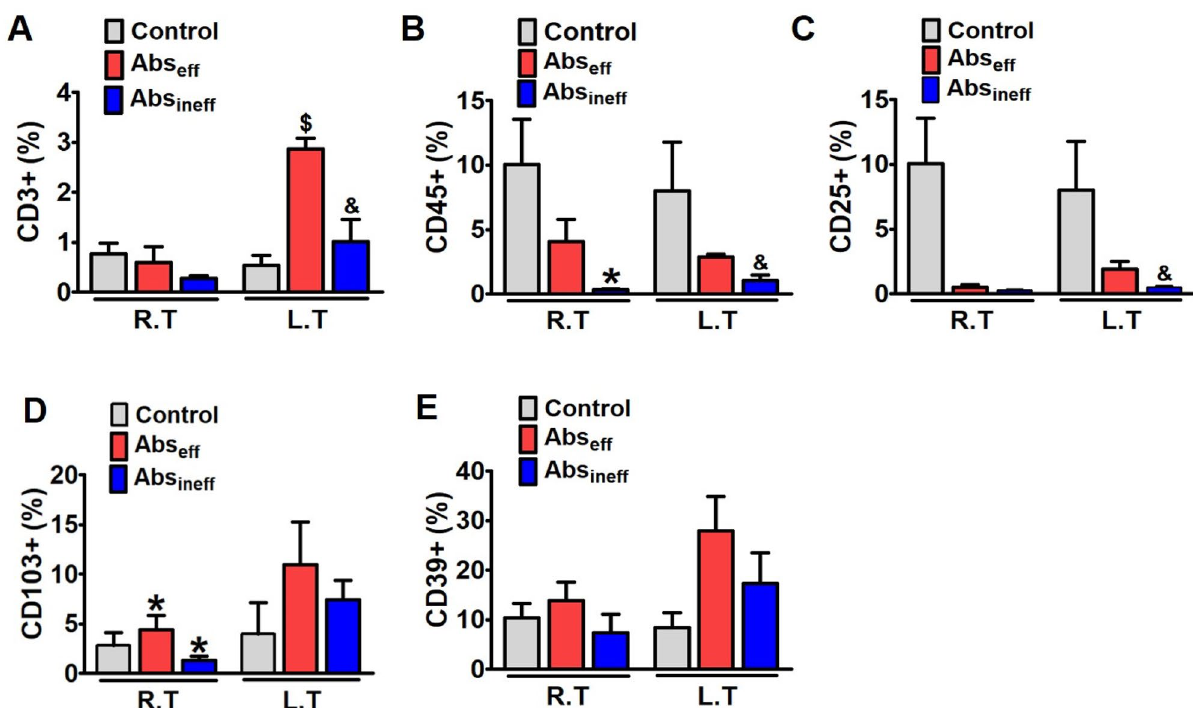
Figure 3. Enhanced accumulation and activation of T cells by Ce6-PDT in the melanoma mouse tumors. ( A - E ) Flow cytometry analysis to count and estimate the intratumoral fraction of ( A ) CD3 + , ( B ) CD45 + , ( C ) CD25 + , ( D ) CD103 + , and ( E ) CD39 + T cells, isolated from the irradiated right and non-irradiated left tumors in control, Abs eff and Abs ineff group. After 28 days of tumor cell injection, T cells in tumor tissues were isolated from B16F10 tumor-bearing mice. Data are from an experiment representative with n = 3 in the control, n = 3 in the abscopal effective, and n = 4 in the abscopal ineffective group. * P < 0.05 compared to right control tumor. #P < 0.05 compared to right tumor of the abscopal effective group, $ P < 0.05 compared to left control tumor, and & P < 0.05 compared to left tumor of the abscopal effective group (by one-way ANOVA with Tukey’s post hoc test for multiple